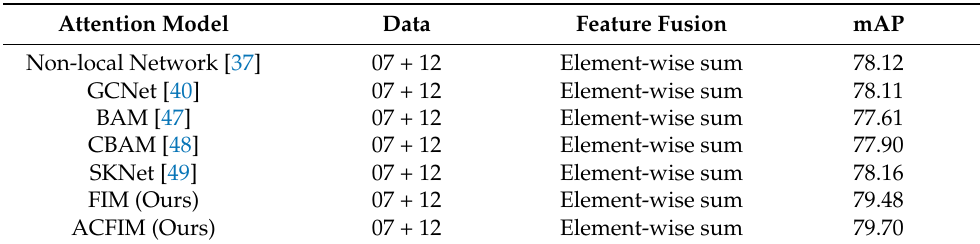
Table 2. Comparison of mAP for different attention models (07 + 12 denotes data are trained with VOC07 and VOC12 trainval sets).